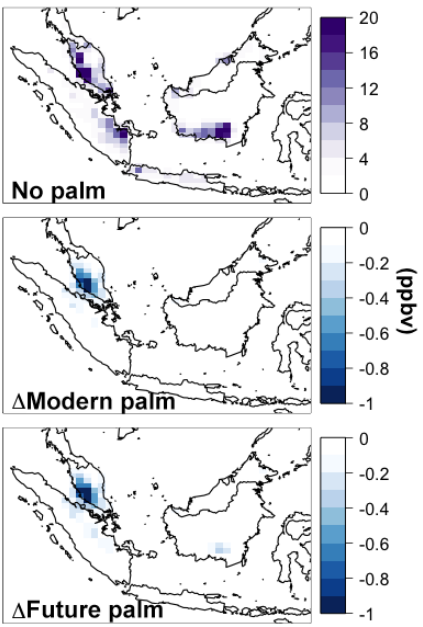
Figure 8. Annual average surface nitrogen oxides (NO x ) concen- trations over SEA (top) and the change due to Modern (middle) and Future (bottom) Palm expansion.